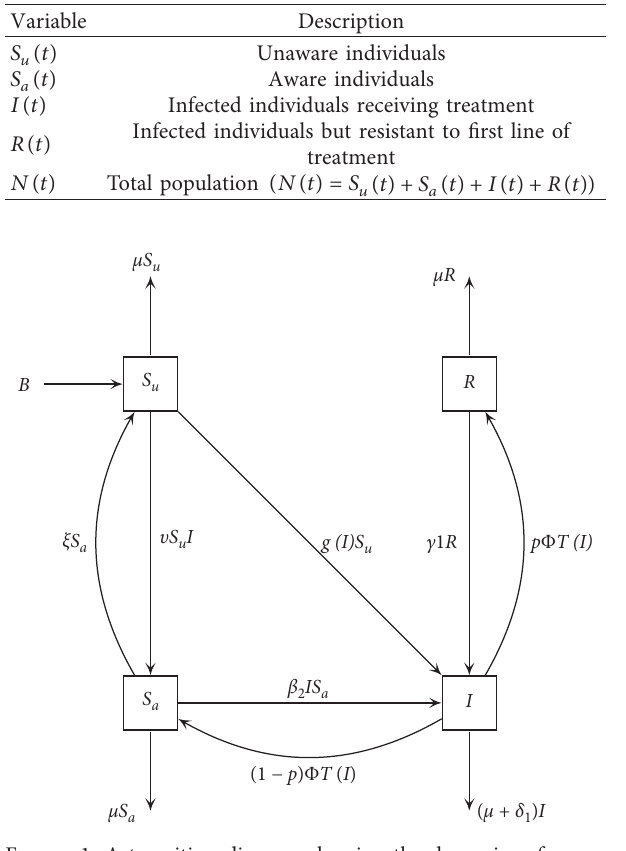
Figure 1: A transition diagram showing the dynamics of pneu- mococcal